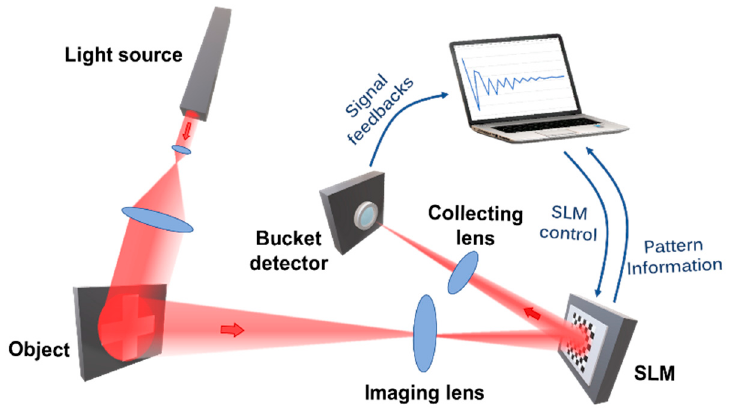
Figure 1. Principle of single-pixel imaging.